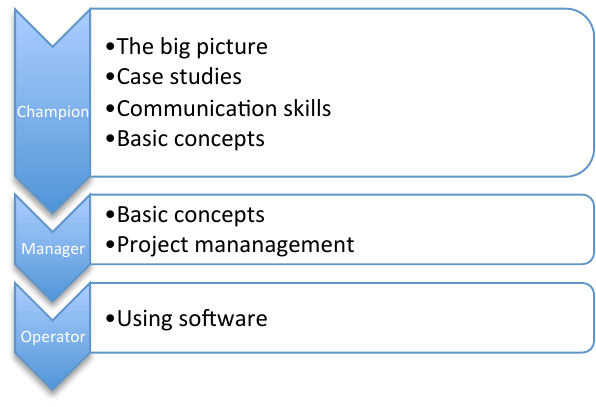
Figure 1. A competency model for Geospatial technology. This progression proposed for AGSI is indicated in Figure 2.